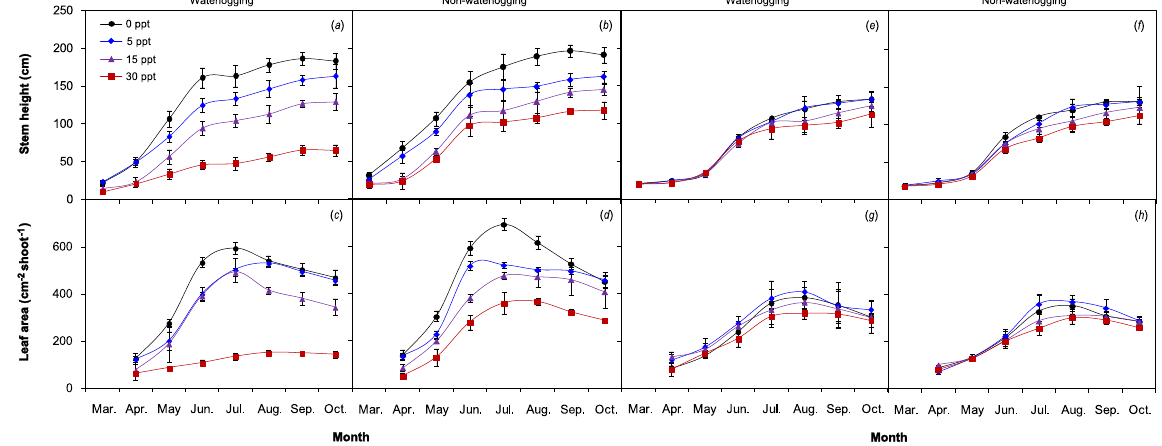
Figure 1. Seasonal variations of stem height and leaf area (mean ± S.D.) of P. australis ( a – d ) and S.